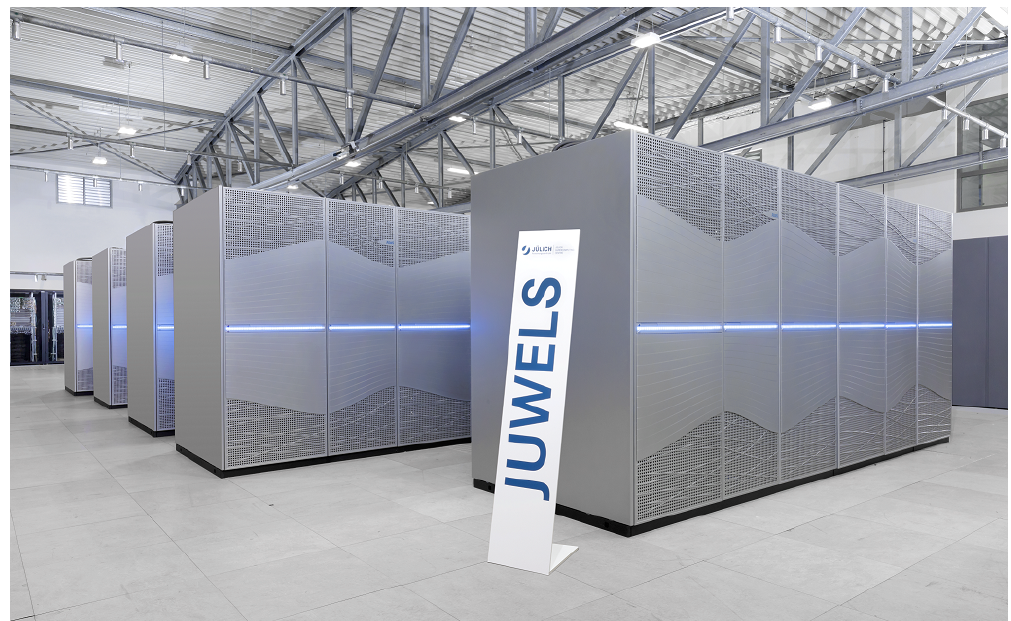
Figure 1: The Cluster Module of the supercomputer JUWELS in the facility of Jülich Supercomputing Centre. Copyright: Forschungszentrum Jülich